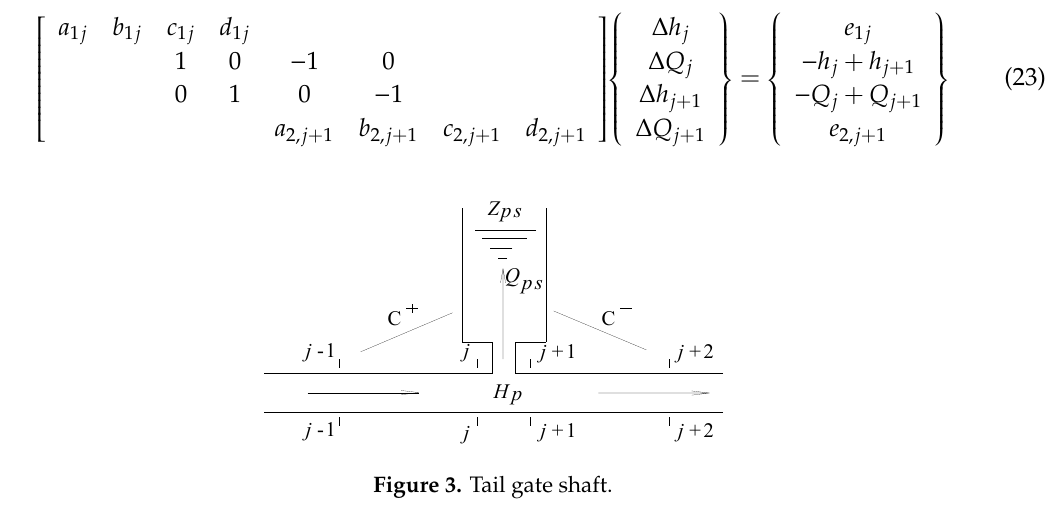
Figure 3. Tail gate shaft.